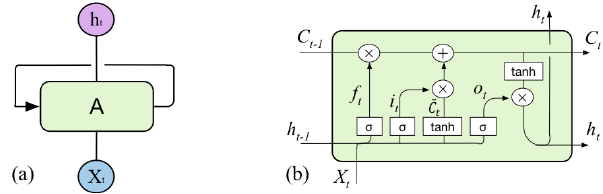
Figure 2. Diagram of an RNN network and LSTM computing cell (from